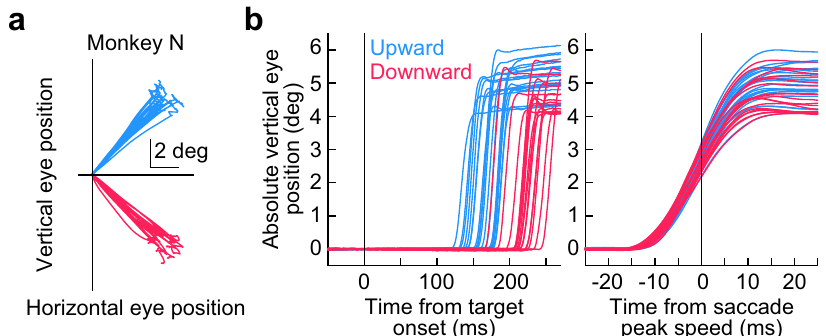
Fig. 3 Upward and downward saccades exhibit strong differences in reaction times, but not kinematics. a From the second database, we plotted, by way of example, similarly-sized oblique saccades from one monkey, and we separated them as being either upward or downward (as in Fig. 2a). b Relative to stimulus onset (left panel), the saccades were very different from each other in terms of their reaction times, as we characterized in detail earlier 36 ; saccades towards the upper visual fi eld (light blue) had signi fi cantly shorter reaction times than saccades towards the lower visual fi eld (light red). However, kinematically, the saccades were very similar when aligned to the time of peak intra-saccadic eye speed (right panel). In both panels, we plotted the absolute value of vertical eye position displacement for each saccade (for better comparison of the upward and downward movements). Figures 4, 5 summarize the saccade kinematic results that we obtained for a much larger number of movements, and for two monkeys. N = 21 upward saccades and N = 18 downward saccades in this fi